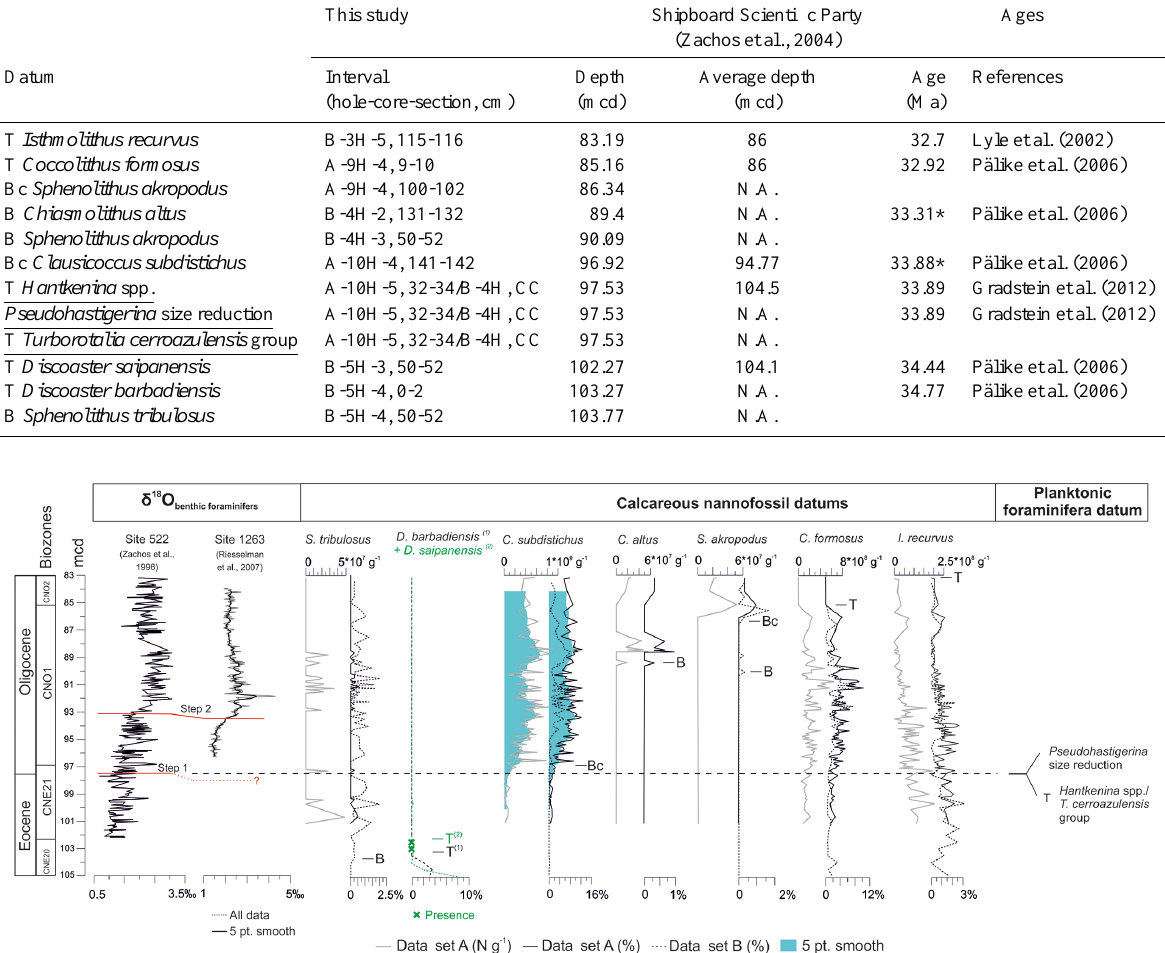
Figure 2. Eocene–Oligocene stratigraphy of Site 1263 and DSDP Site 522 (Walvis Ridge). Stable oxygen isotope stratigraphy ( δ 18 O, ‰) at DSDP Site 522 (Zachos et al., 1996) compared to that at Site 1263 (Riesselman et al., 2007). Absolute abundances of nannofossil marker species (Ng − 1 ; note 10 7 –10 8 –109 change in scale among curves) for data set A (grey line) and their relative percentages (%) for data sets A (black line) and B (black dashed). A five-point smoothed curve is shown for the species C. subdistichus . Note the changes in horizontal scale among curves. Calcareous nannofossil and planktonic foraminiferal datums are highlighted. B: base occurrence; T: top occurrence; Bc: base common